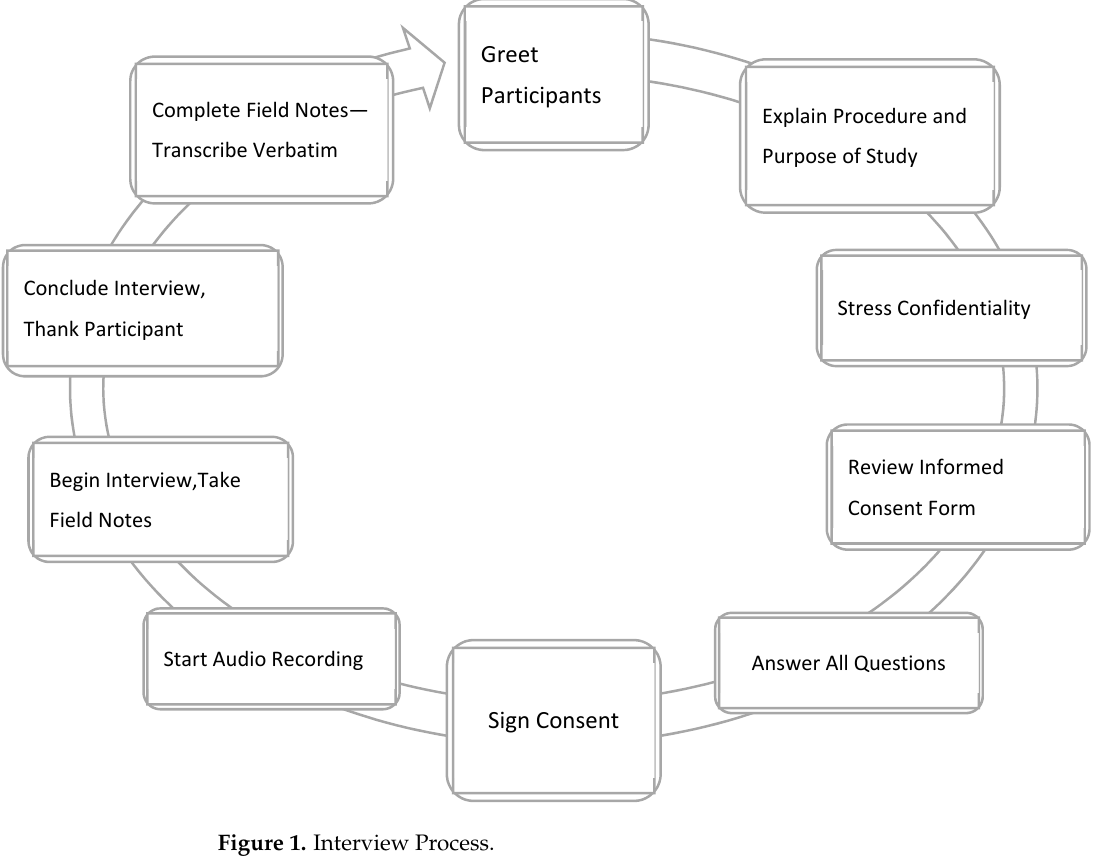
Figure 1. Interview Process.